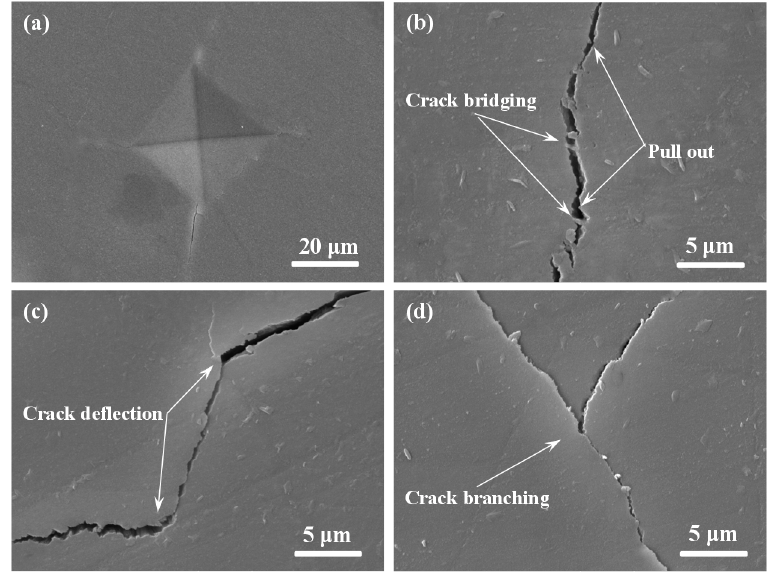
Figure 6. Toughening mechanisms observed on the polished scaffolds with 5 wt % ZnOw: ( a ) Vickers indentation; ( b ) crack bridging and pull-out; ( c ) crack deflection; and ( d ) crack branching